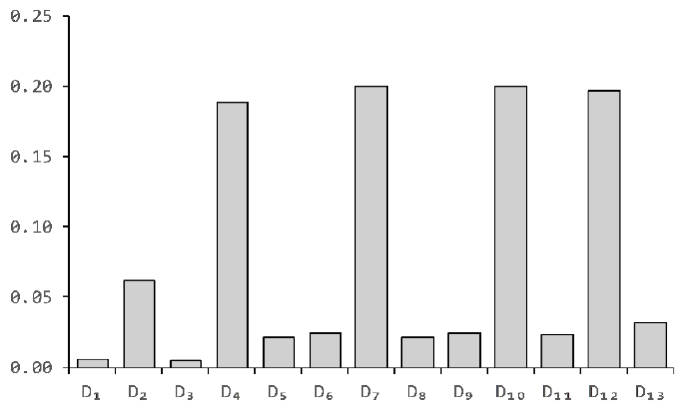
Figure 5. Histogram of the weight of each indicator.